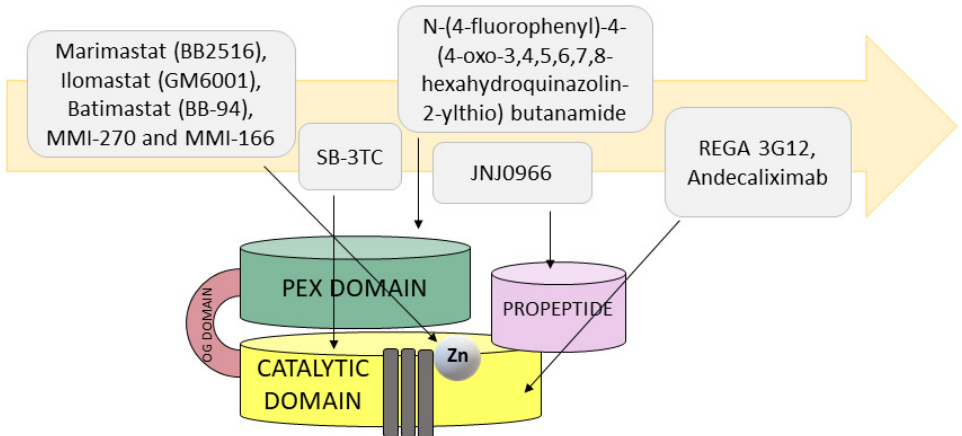
Figure 3. Alternative mechanisms for targeting MMP9 lead to enhanced specificity. Starting from the nonspecific small MMP9 inhibitors that chelate zinc ions (e.g., marimastat, ilomastat, and batimastat), through inhibitors targeting other than catalytic domain (N-(4-fluorophenyl)-4-(4-oxo-3,4,5,6,7,8-hexahydroquinazolin-2-ylthio) butanamide; JNJ0966) and ending with function blocking antibodies (REGA 3G12, andecaliximab), which in addition to blocking the activation of MMP9 also inhibit MMP9 activity and substrate binding. The yellow arrow symbolizes increasing specificity of MMP9